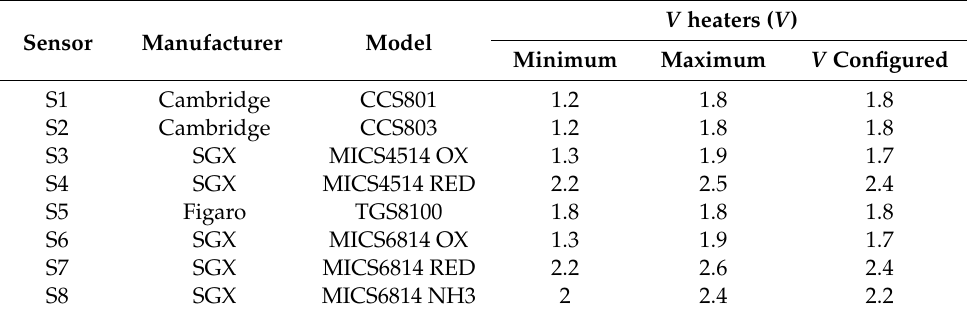
Table 4. Sensors used by WINOSE 6.